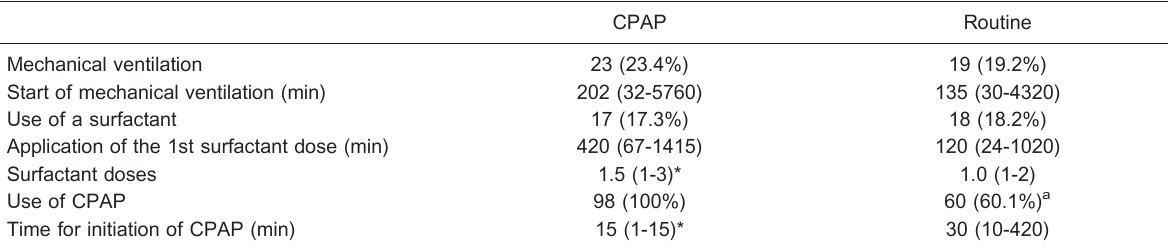
Table 3. Need for mechanical ventilation and use of a surfactant during the first 5 days of life according to study